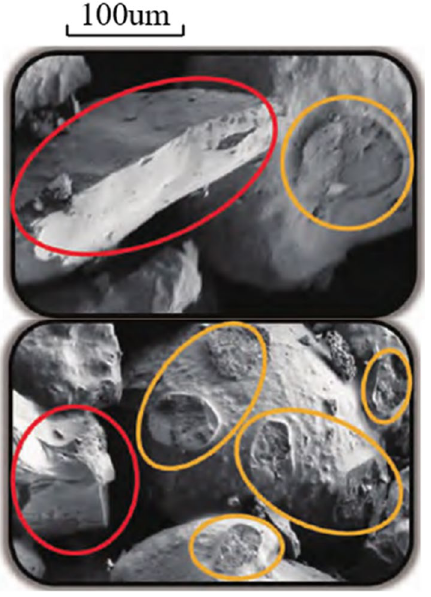
Fig. 13 Granular structure of the sample section under dynamic mechanical testing (Jiang et al.